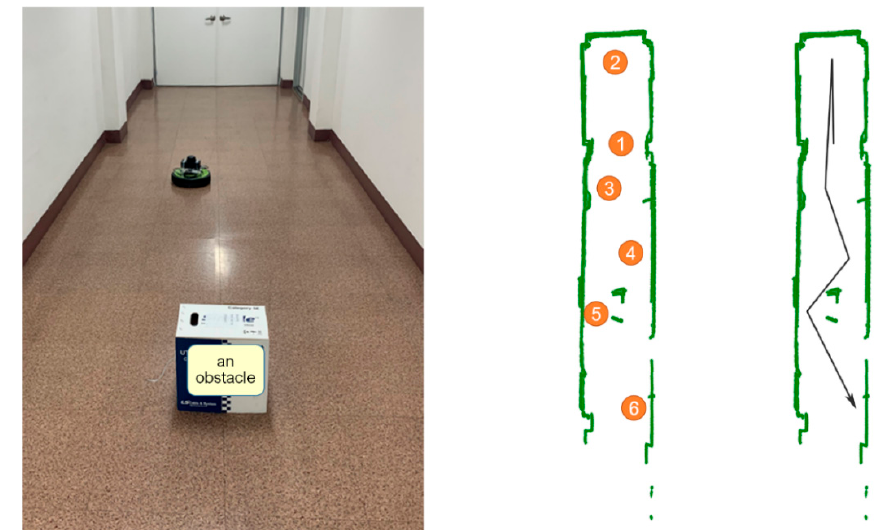
Figure 34. Indoor space (corridor with an obstacle) wherein autonomous scanning experiment was performed ( left ) and integrated image of scanned result in experiment. The numbers indicating the positions after movement form the starting position of the autonomous scanner ( middle ); also, the trajectory of the autonomous scanner is indicated ( right ).